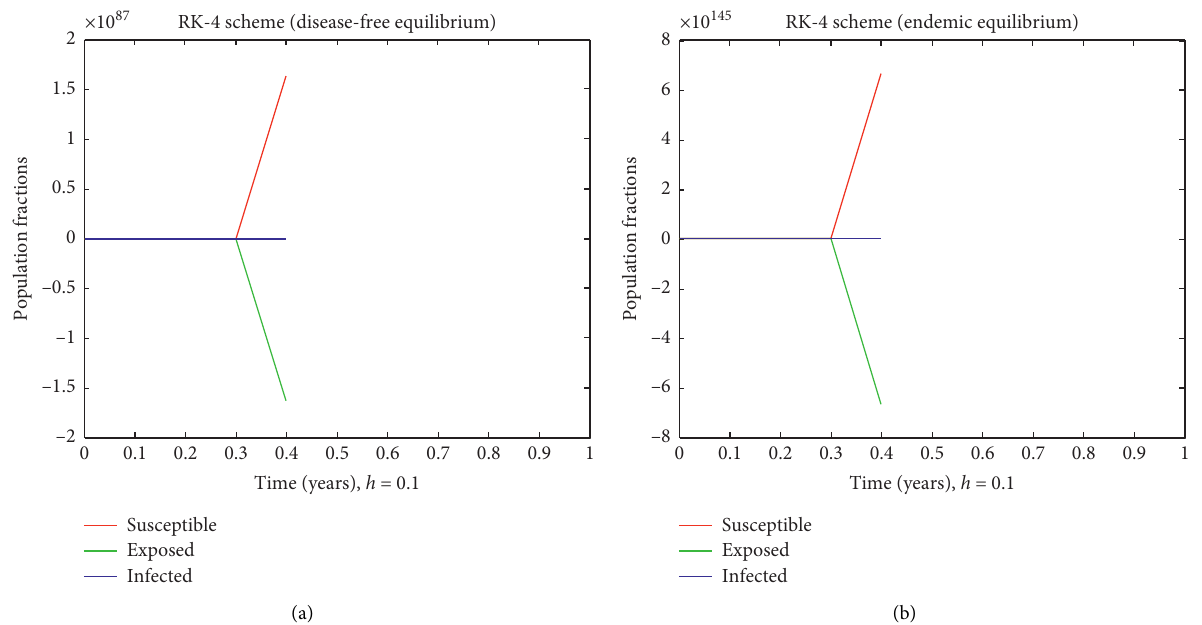
Figure 6: Divergence graphs of the population using the RK-4 method with step size h � 0 . 1